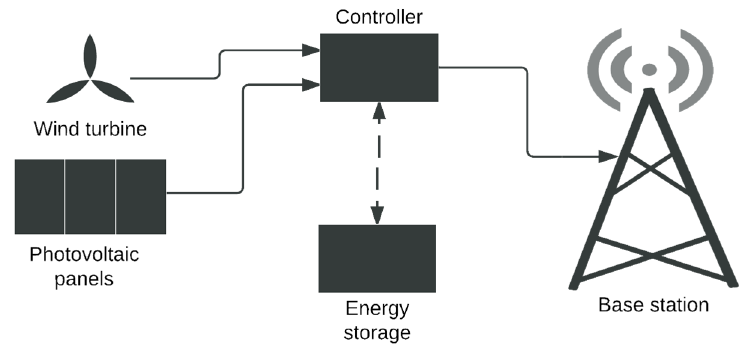
Figure 2. Typical configuration of a hybrid PV-wind system in a base station